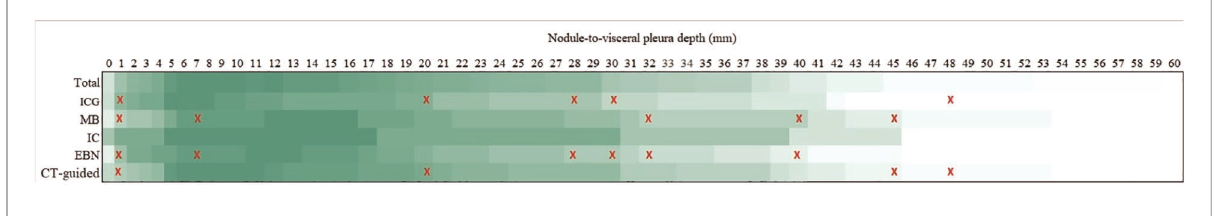
FIGURE 1 Localization effectiveness of the main techniques according to the depth from the nodule to the visceral